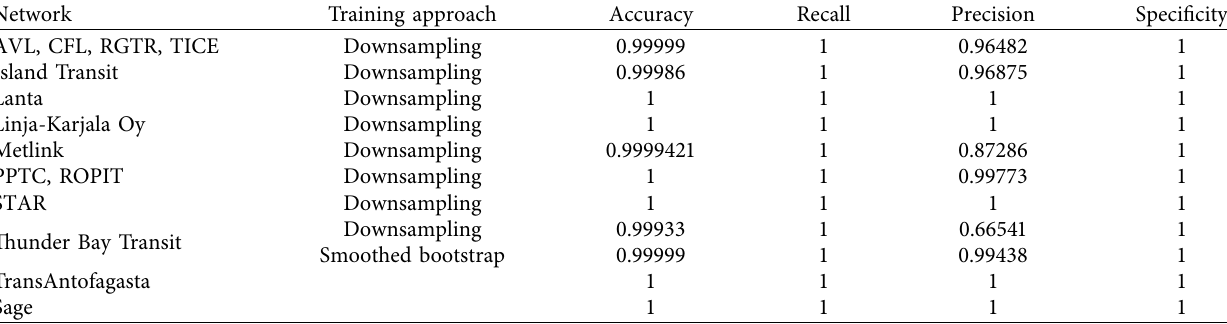
Table 8: Final validation. Accuracy, recall, precision, and specificity parameters. Network